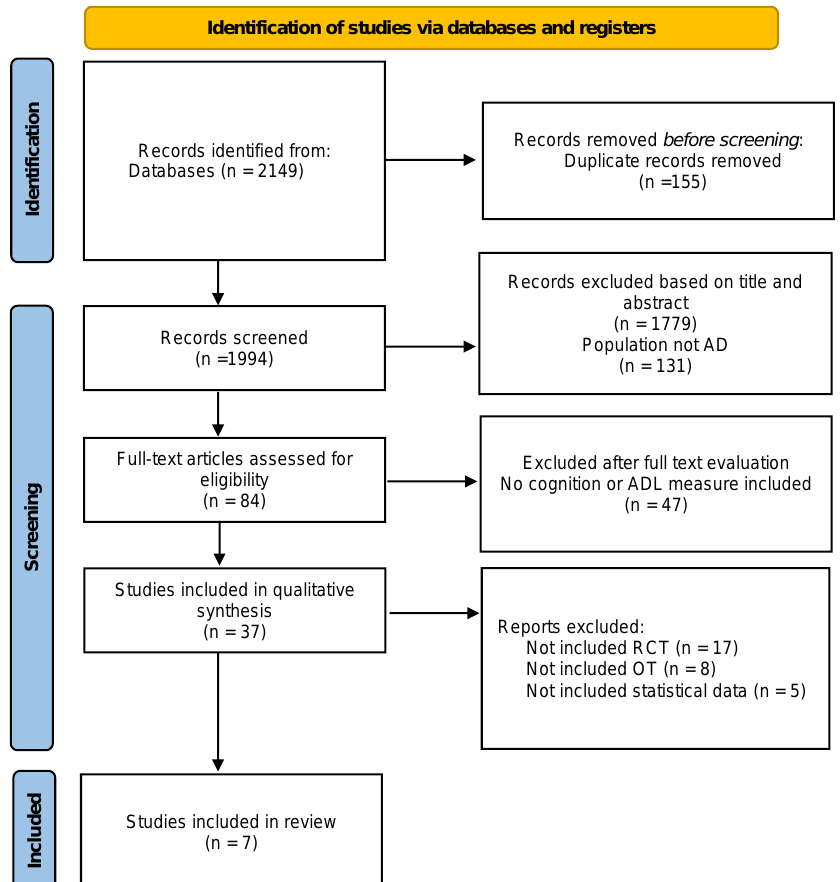
Figure 1. Flow diagram of the study selection process.